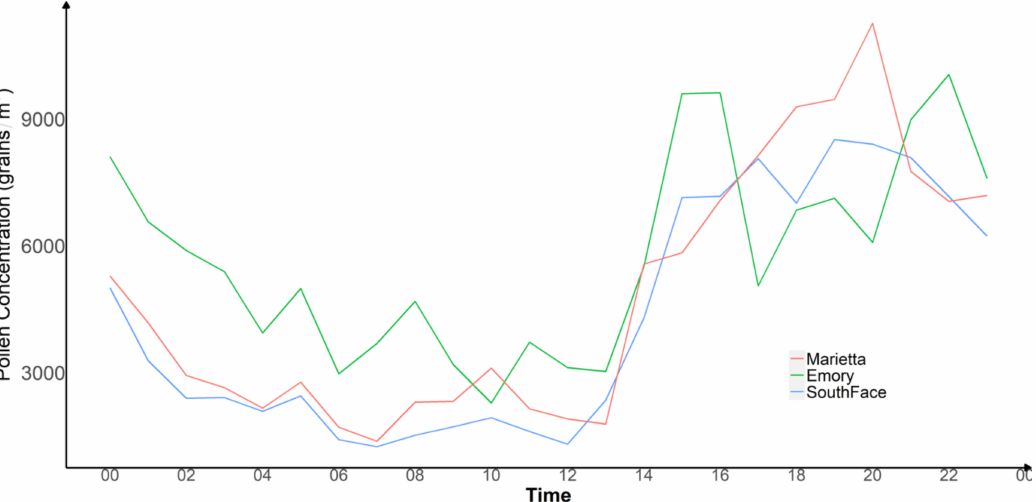
Figure 6. Real-Time Pollen Monitoring of Three Devices from 12 p.m. of 24 March to 12 p.m. of 31 March